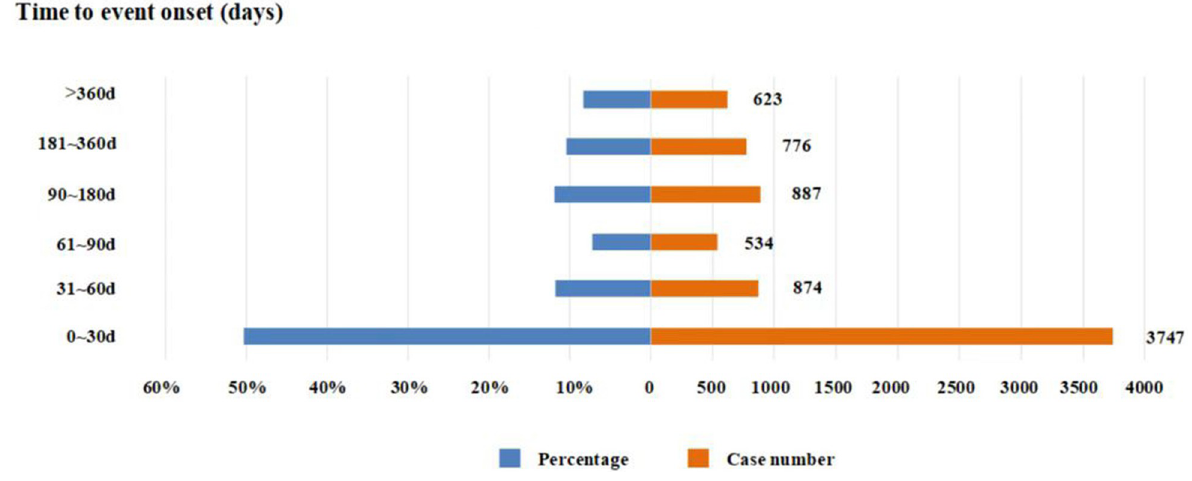
Fig 1. Time to onset of venetoclax-related